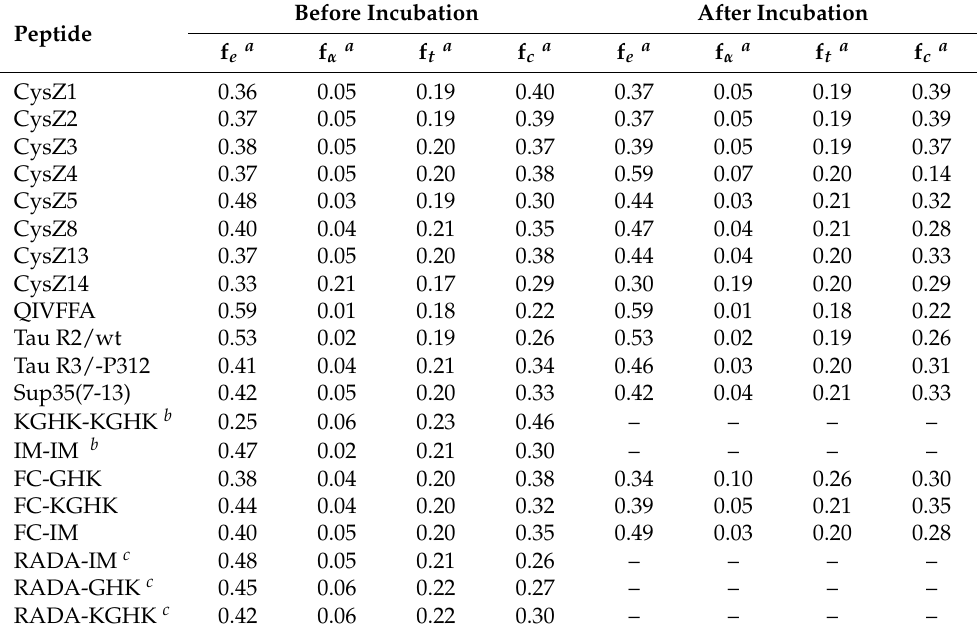
Table 2. Fractions of secondary structure of the solutions of the peptides studied before and after incubation determined from CD measurements. Before Peptide